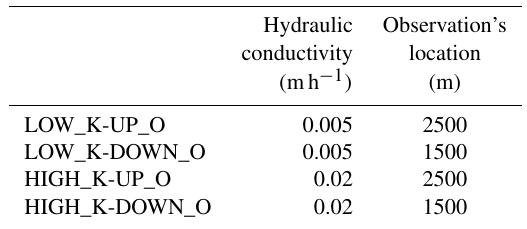
Table 1. Configuration of the data assimilation experiments in Sect. 3.1.